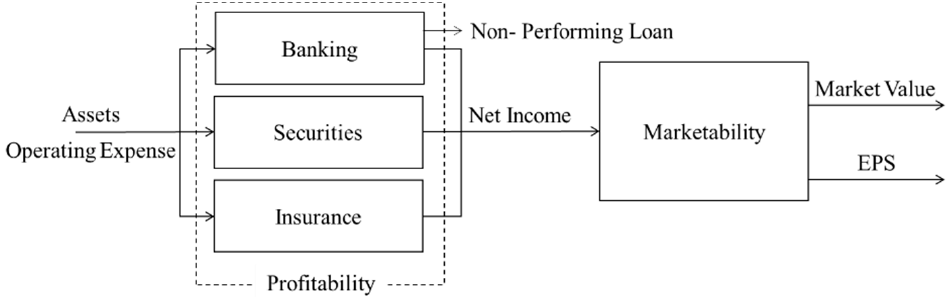
Figure 2. The modified two-stage value creation framework for Taiwanese financial holding companies including three main financial subsidiaries. Table 1. Variables and descriptions.